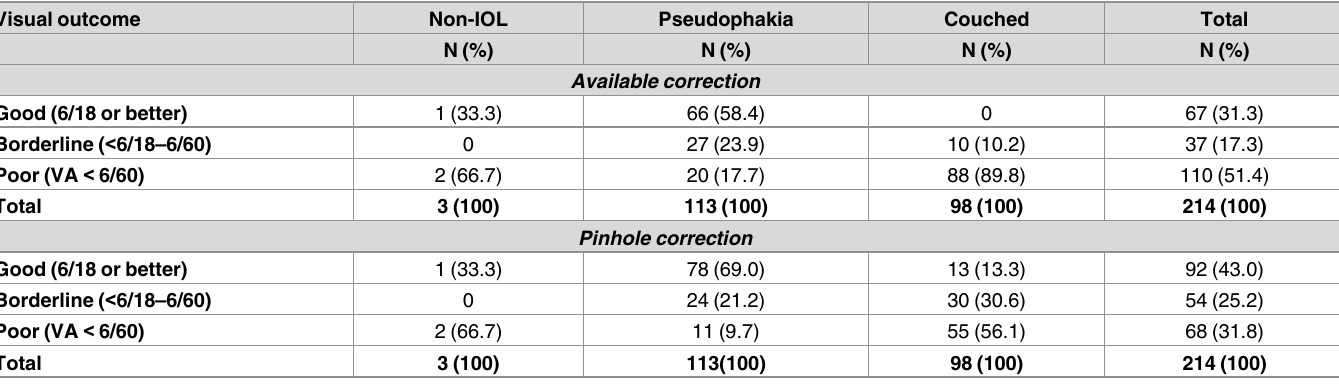
Table 4. Visual outcome after cataract intervention (eyes):Wurno health zone 2016.